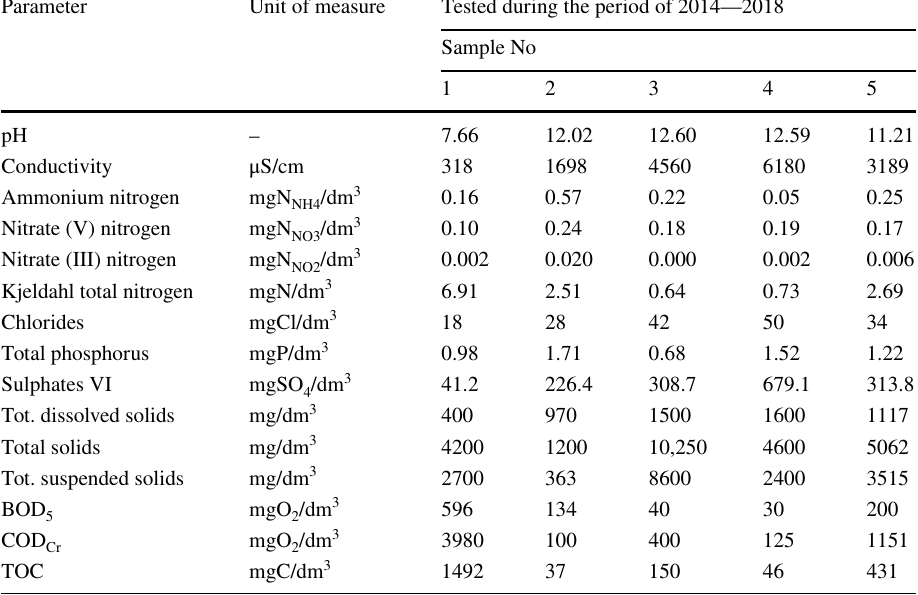
Table 2 Averaged results of physicochemical analysis of leachate samples